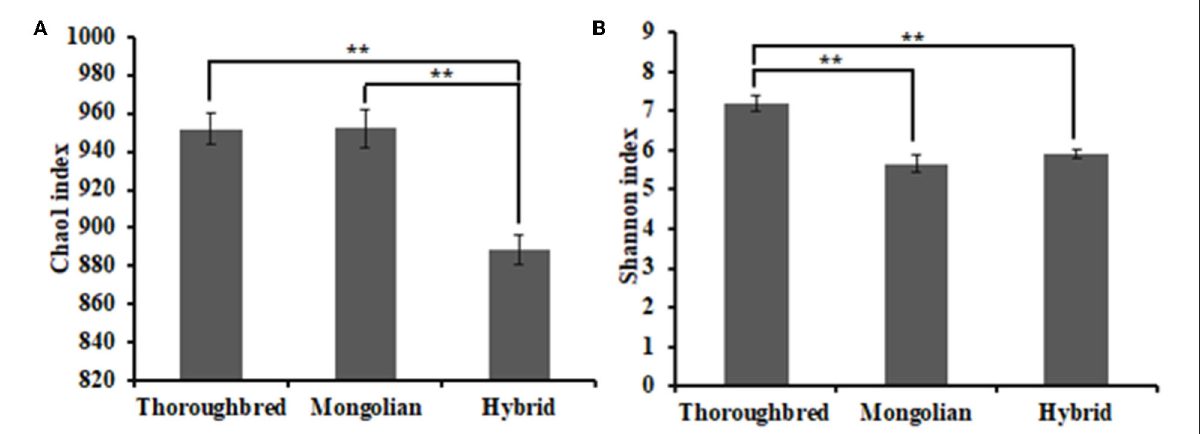
FIGURE3 Analysis of beta diversity of microbial community between Thoroughbred, Mongolian, and Hybrid horses. (A) NMDS analysis (non-metric multidimensional scaling, using unweighted UniFrac algorithm). (B) UPGMA tree (unweighted pair group method with arithmetic mean, using weighted UniFrac algorithm). T, Thoroughbred horses; M, Mongolian horses; H, Hybrid horses.